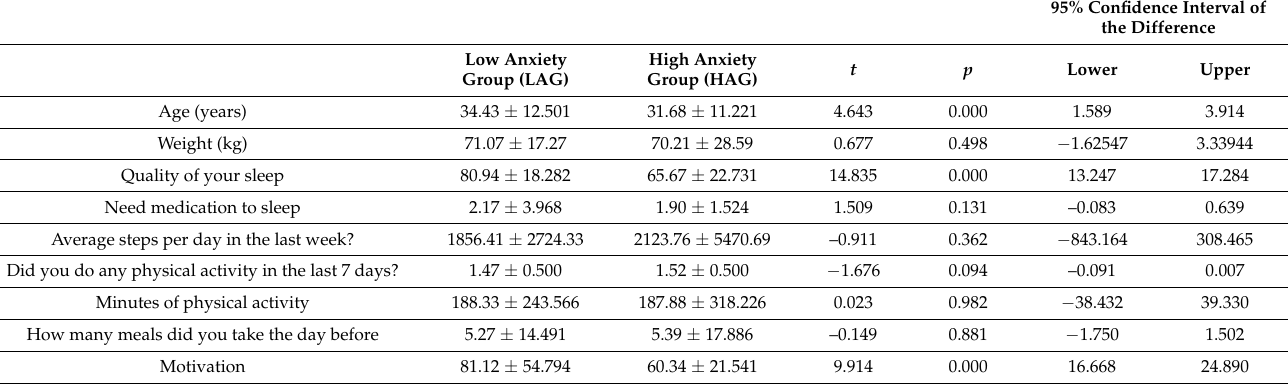
Table 2. Behavioral